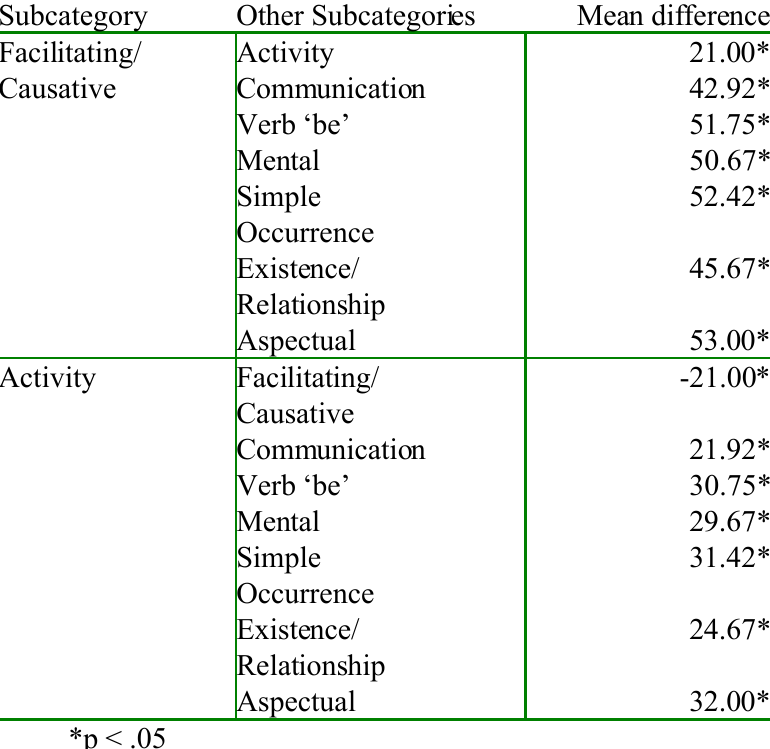
Scheffé Post Hoc Comparisons of Verb